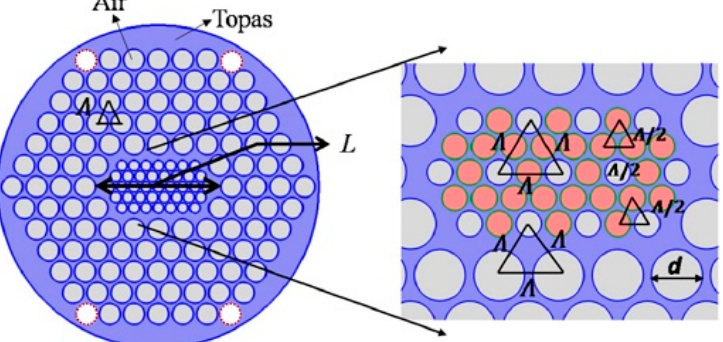
Figure 1. Cross section of the designed fiber (red dashed air holes in the cladding are missing, and orange colors in the core are intermediate air holes introduced to induce birefringence).